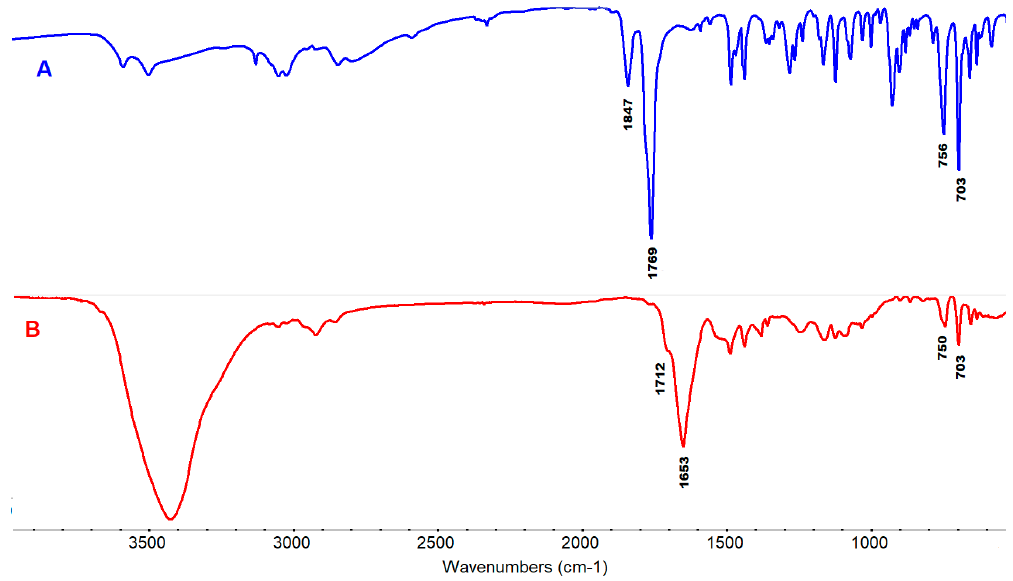
Figure 11. FT-IR spectra: ( A ) of N im -Trt-HIS NCA; and, ( B ) after the completion of polymerization.